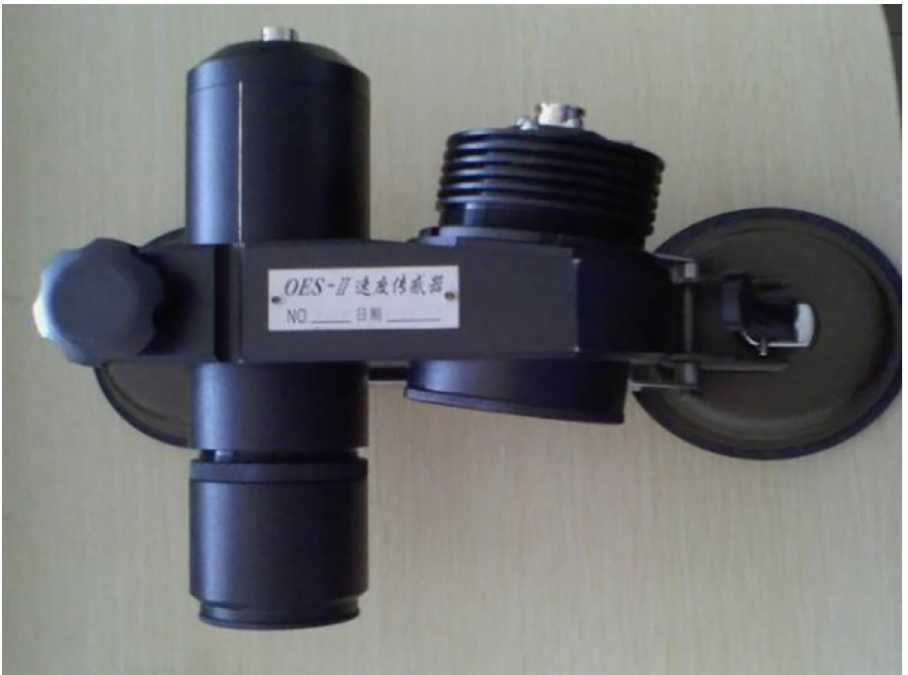
Fig 3. Non-contact velocimetry with multi-function.